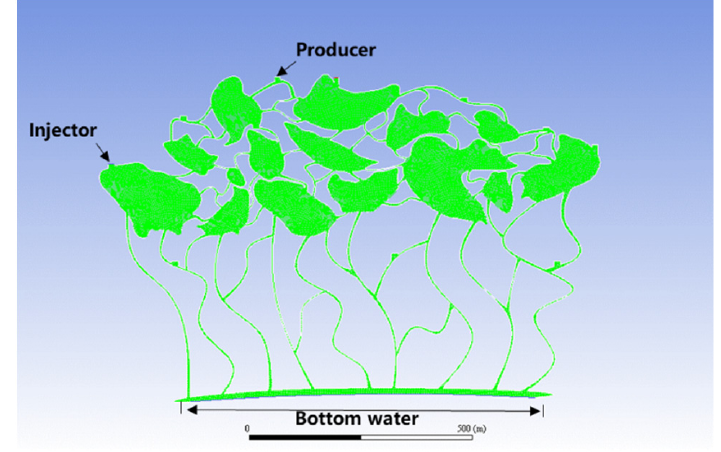
Figure 3. Conceptual numerical model.